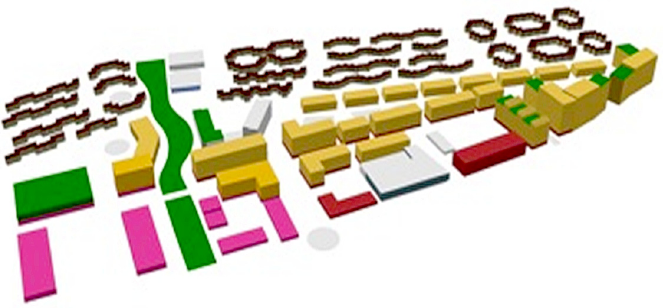
Figure 2. 3D model imported into ArcScene in .dae format.